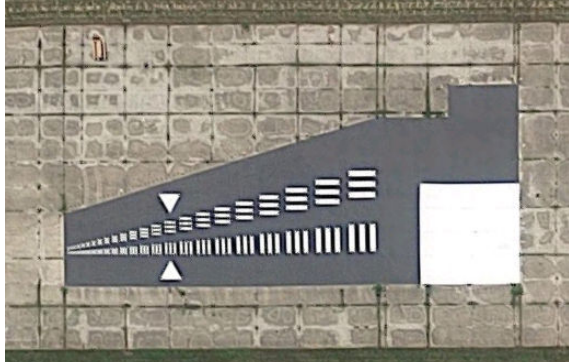
Figure 3. Bar target calibration test at Wright Patterson OSMPF, USA. (Google Earth)